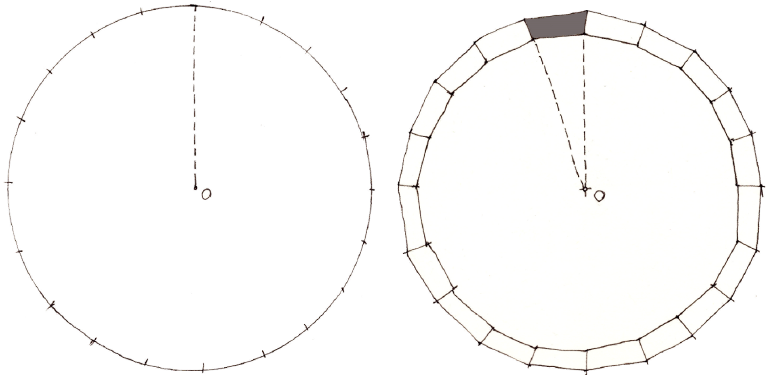
Figure 9. Drawing on the initial circular stroke for the assembly of the Corraleja, and the definition of the polygonal line through the determination of the basic module ( palco ) of the Corraleja. Source: Massimo Leserri, 2017 [4].